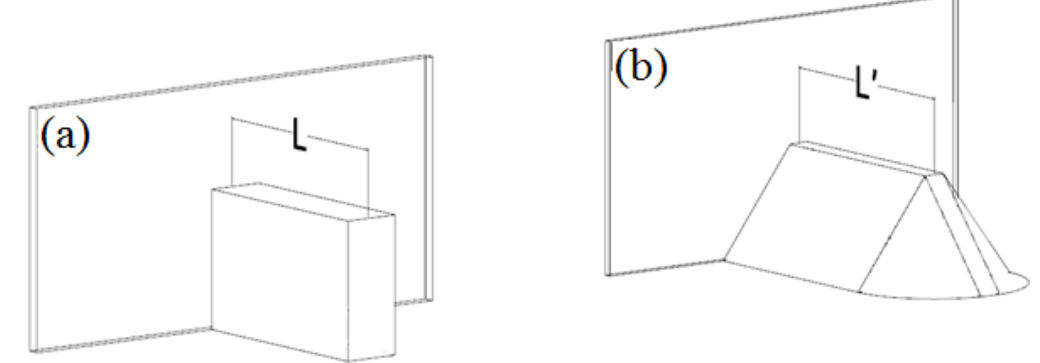
Figure 2. Schematic illustration of the abutments: ( a ) Vertical wall; ( b ) Spill-through. Riprap stones in the form of fine gravel with median grain size 𝐷 𝑅50 = 7 mm were used in this study. The riprap stones were selected based on the study of Chiew [9]. Sim- ilar scale ratios of riprap stones also were used by Cardoso et al. [21] for abutment coun- termeasures ( 𝐷 𝑅50 = 7 mm 𝑎𝑛𝑑 𝑑 50 = 0.96 mm ) and Zarrati et al. [35] for pier counter- measure ( 𝐷 𝑅50 = 5 mm 𝑎𝑛𝑑 𝑑 50 = 0.95 mm) in their studies. The scale ratios of the apron ( 𝑎 𝑅 , 𝑏 𝑅 and 𝑡 , see Figure 3 for the definition of these scale ratios), which are selected ac- shown in Table 1.